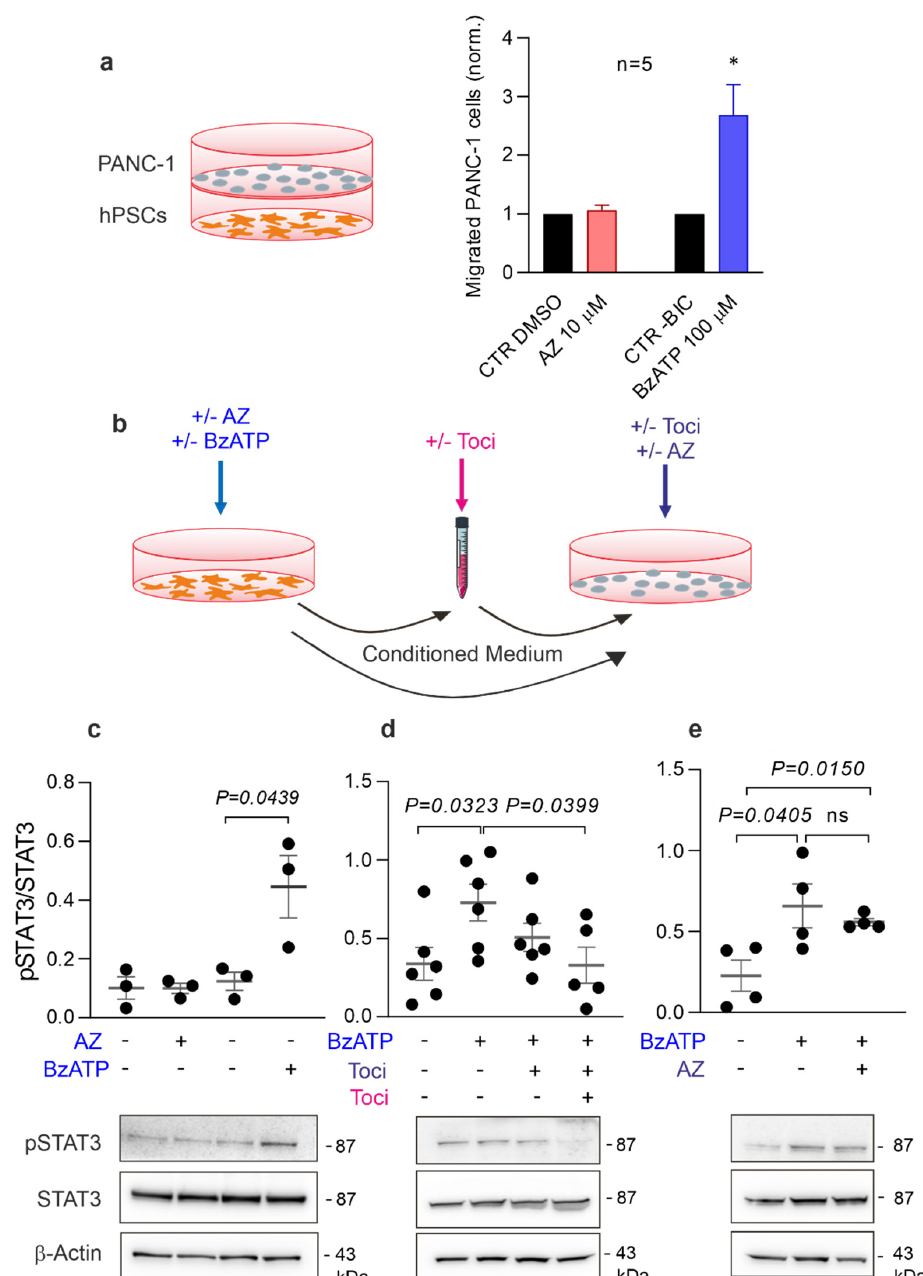
Figure 5. Effect of hPSCs and conditioned media on PANC-1. ( a ) Schematic diagram of Boyden chamber experimental setup showing PANC-1 cells in the upper chamber and hPSCs in the lower chamber. The histogram shows the number of migrated PANC-1 cells after co-incubation with hPSCs treated with either AZ10606120, AZ, (10 μ M) or BzATP (100 μ M) normalized to either a DMSO or –BIC control, in which the drugs were dissolved, respectively. * p < 0.05. ( b ) Schematic diagram of the experimental setup for ( c , e ), where conditioned media was harvested from hPSCs and added to PANC-1 cells. The hPSCs were treated with +/-P2X7R agonist (BzATP, 100 μ M) or antagonist (AZ, 10 μ M) (blue), the conditioned media was treated with +/- 10 ng/mL Tocilizumab (Toci) (pink), and PANC-1 cells were treated with either +/- 10 ng/mL Toci and +/- 10 μ M AZ (purple). ( c , e ) Representative Western blots and quantification of STAT3 activation in PANC-1 cells after stimulation with conditioned media from hPSCs. STAT3 activation is reported as pSTAT3/total-STAT3 ( c ). The same experiment has been repeated inhibiting IL-6 receptors on PAN-C1 cells or on PANC-1 cells and CM ( d ). PANC1 pre-treatment with AZ10606120 (10 μ M) has been performed to exclude a potential impact of P2X7R activation on STAT3 activation in PANC1 ( e ). β -actin was used as a loading control. Significant P values are shown in the graph and ns indicates non-significance.